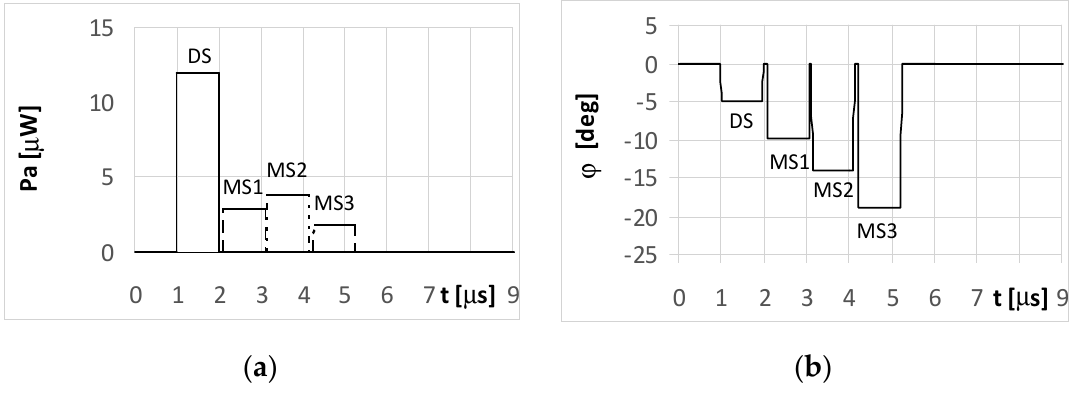
Figure 5. Envelopes of the direct signal (DS) and multipath signals (MS1, MS2, MS3) reflected from the ground, separated in time, and reaching UAV1 (shown in Figure 1) ( a ), and temporary angle of arrival ϕ estimated from the received resultant signal ( b ), (for simple and linear frequency modulation ( LFM) short pulsed signal as transmitted from the radar, pulse duration t i = 1 µ s , and initial phases Φ 0D = Φ 01 = Φ 02 = Φ 03 =0 ° ; angle of arrival (AOA) was estimated using the monopulse phase method from the DF device installed on UAV1 ).